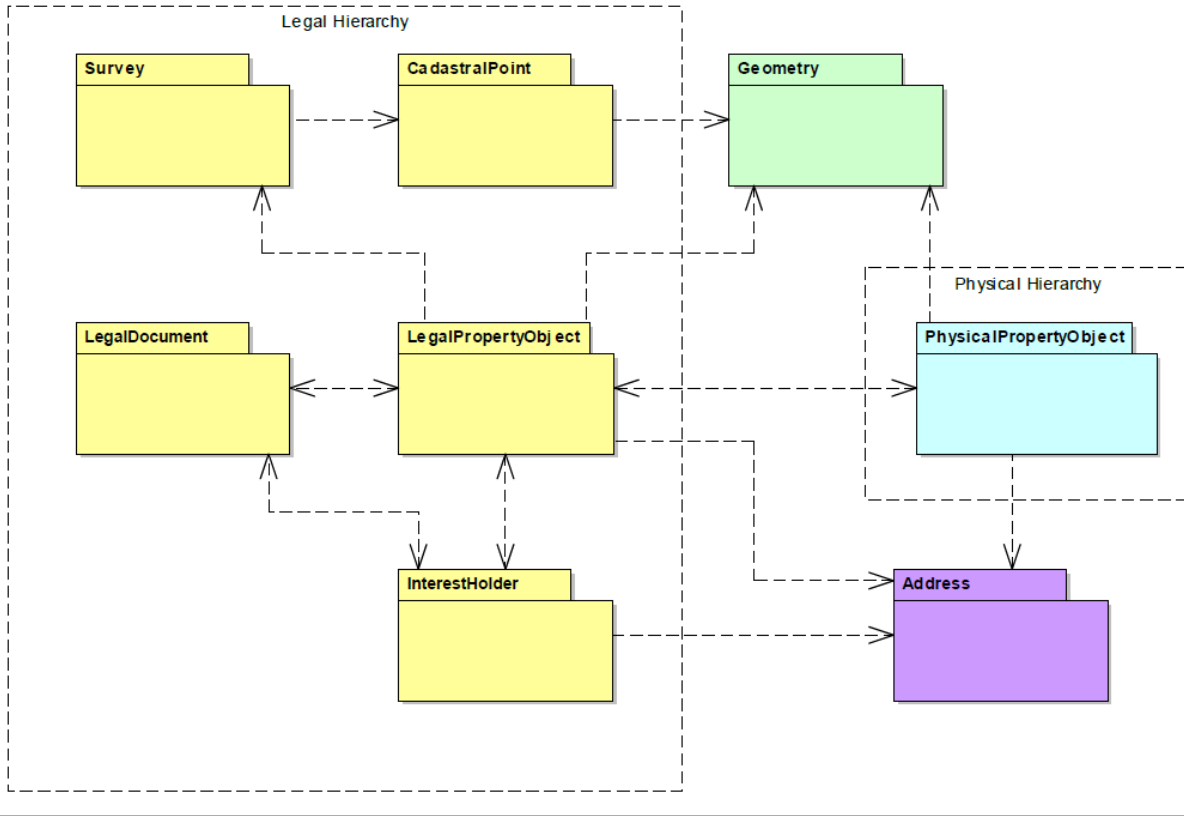
Figure 8. Conceptual Model of the